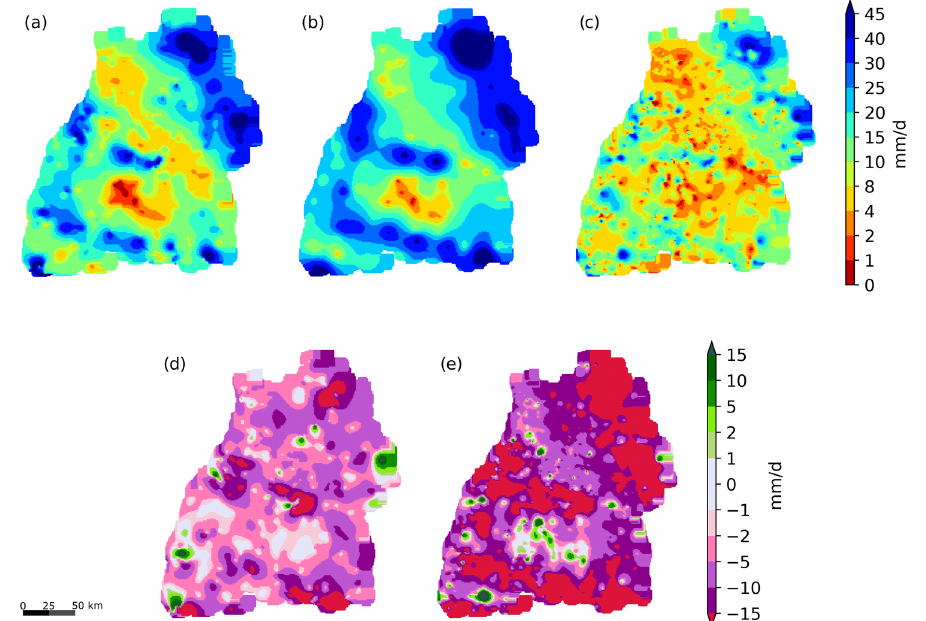
Figure 12. Interpolated precipitation for the time period for a 24h event from 00:00 to 24:00LT on 14 May 2018 (a–c) and the differences between primary and combination and primary and secondary data-based interpolations. Panel (a) shows the result after applying the filtering, (b) the interpolation from the primary network and (c) the one from the secondary network. Panels (d) and (e) depict the differences between (a) and (b) and (c) and (b) ,